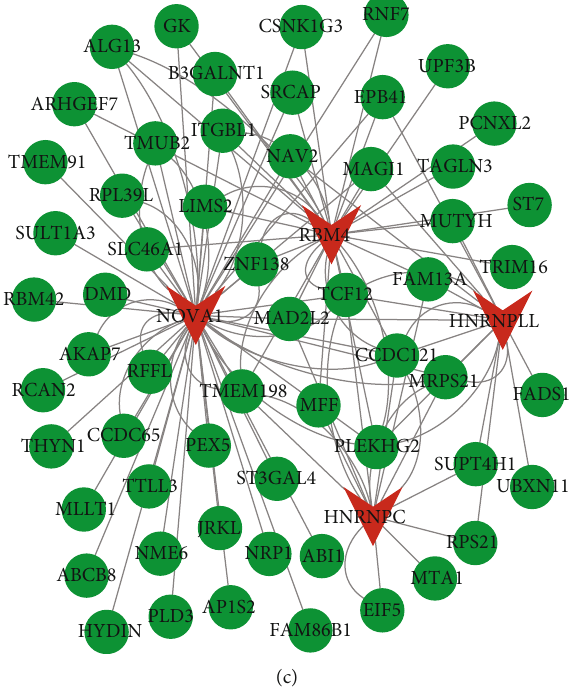
Figure 4: SFs in glioma. (a) Survival curve of SFs. (b) Correlation analysis of the splicing factor and AS prognostic predictor. The upper right fi gure shows the signi fi cance of the correlation between the correlation coe ffi cient and SF expression and the PSI value of prognostic-related AS events, where ∗ p < 0 : 05 , ∗∗ p < 0 : 01 , and ∗∗∗ p < 0 : 001 ; the lower left fi gure shows a pie chart of the correlation between SF expression and the PSI value of survival-related AS events, where the size of the pie chart represents the correlation, the green line represents the negative correlation, and the red line represents the positive correlation. (c) The AS network, where the green node represents the gene involved in the di ff erential AS event and the red node represents the AS